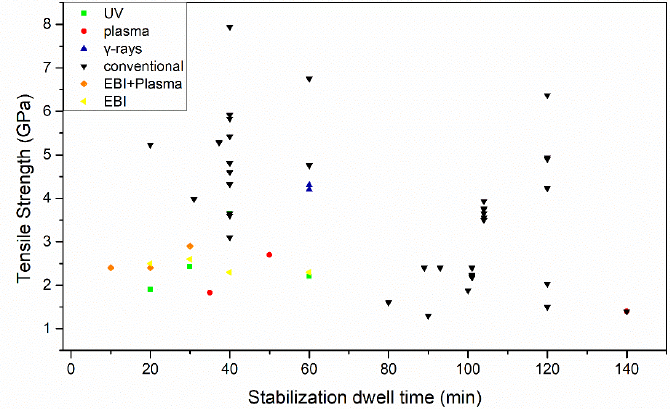
Figure 5. Tensile strength versus stabilization duration based on literature data presented in Figure 3.